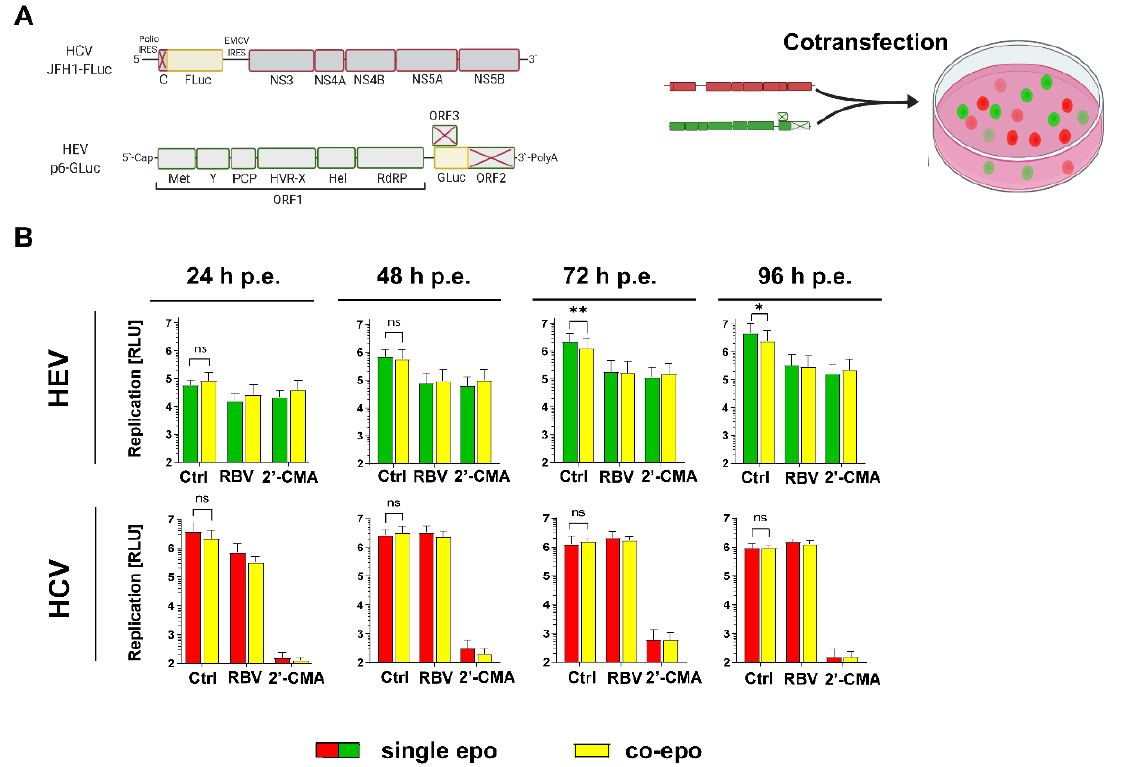
Figure 1. Co-replication of HCV and HEV in Huh7.5 cells. ( A ) Scheme of the subgenomic replicon constructs used for co-replication studies. ( B ) Huh7.5 cells were transfected with HEV p6 subgenomic replicon harboring a Gaussia luciferase and HCV subgenomc replicons harboring a Firefly luciferase reporter gene for dual luciferase measurement. Shown are respective luciferase counts in samples har- vested at the indicated h post electroporation (h p.e.). A total of 10 µ M 2 (cid:48) C methyladenosine (2 (cid:48) CMA, HCV) and 25 µ M ribavirin (RBV, HEV) were added 4 h post electroporation, as replication controls for the respective viruses. Depicted are mean ± SD from three independent experiments. (Statistical significance was calculated using a one-tailed paired t -test). * = p -value < 0.05; ** = p -value <